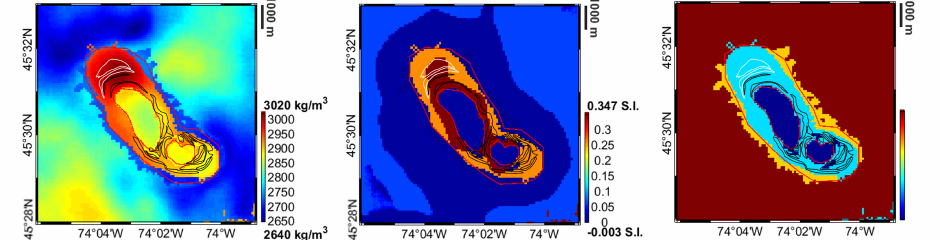
Figure 6. Density and susceptibility distributions and label model from the final solution at 1 km depth. White lines are boundaries of known main okaite formations and black lines are boundaries of main melteigite-urtite formations digitized from Figure